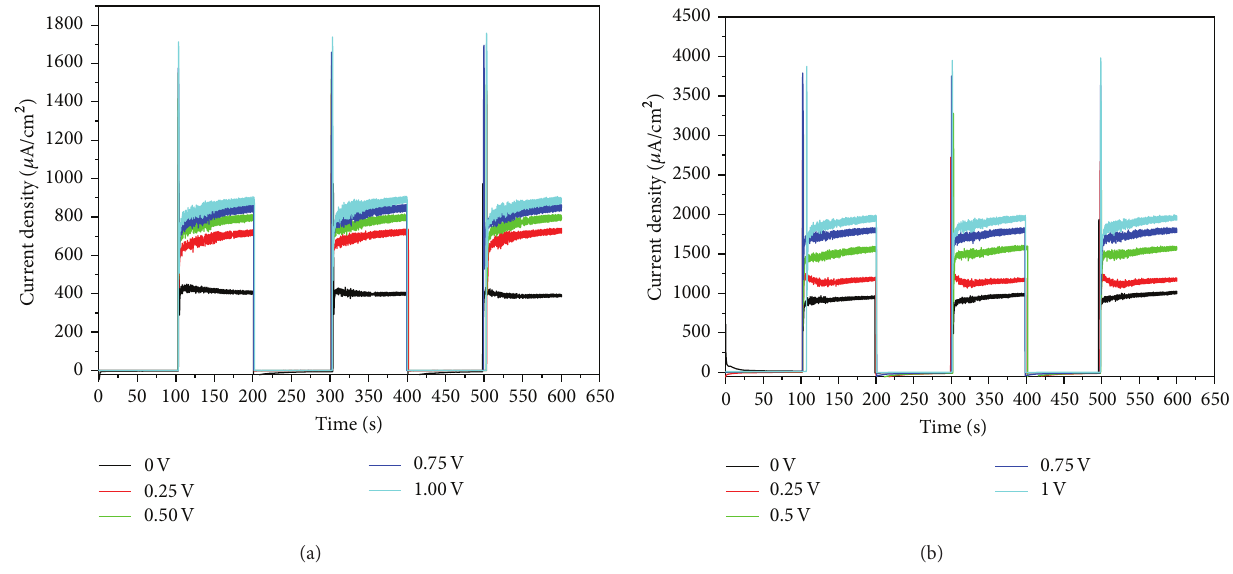
Figure 8: Photocurrent profile of (a) Ag/TiO 2 and (b) P-Ag/TiO 2 at various applied bias voltages under solar illumination.